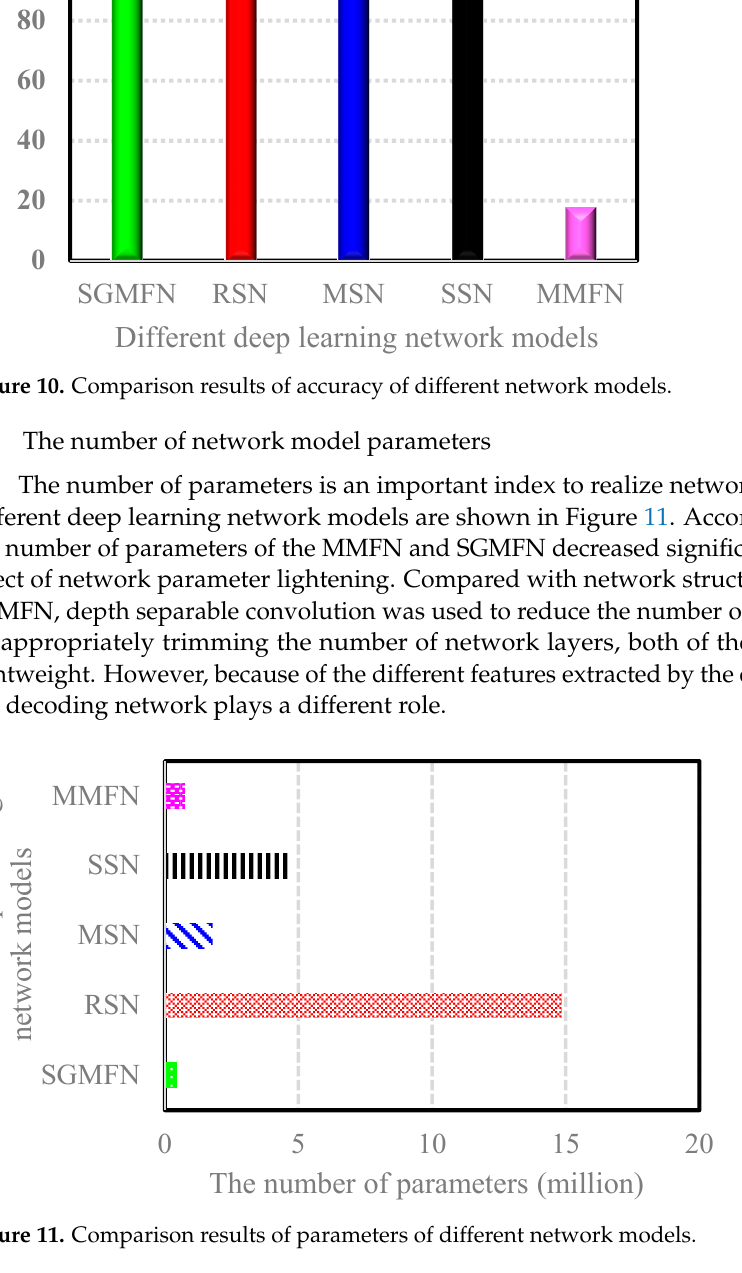
Figure 11. Comparison results of parameters of different network models.